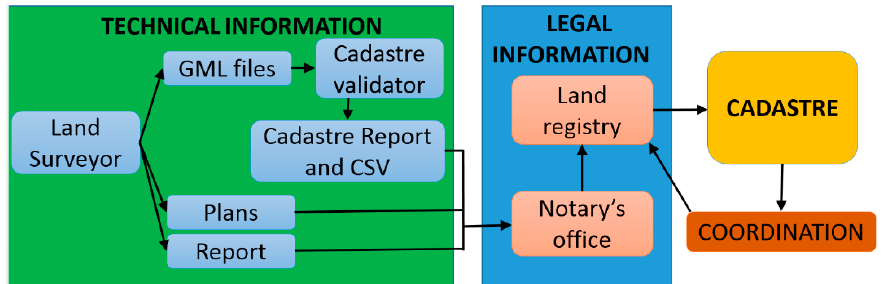
Figure 4. Roles in land administration in Spain. Source: own